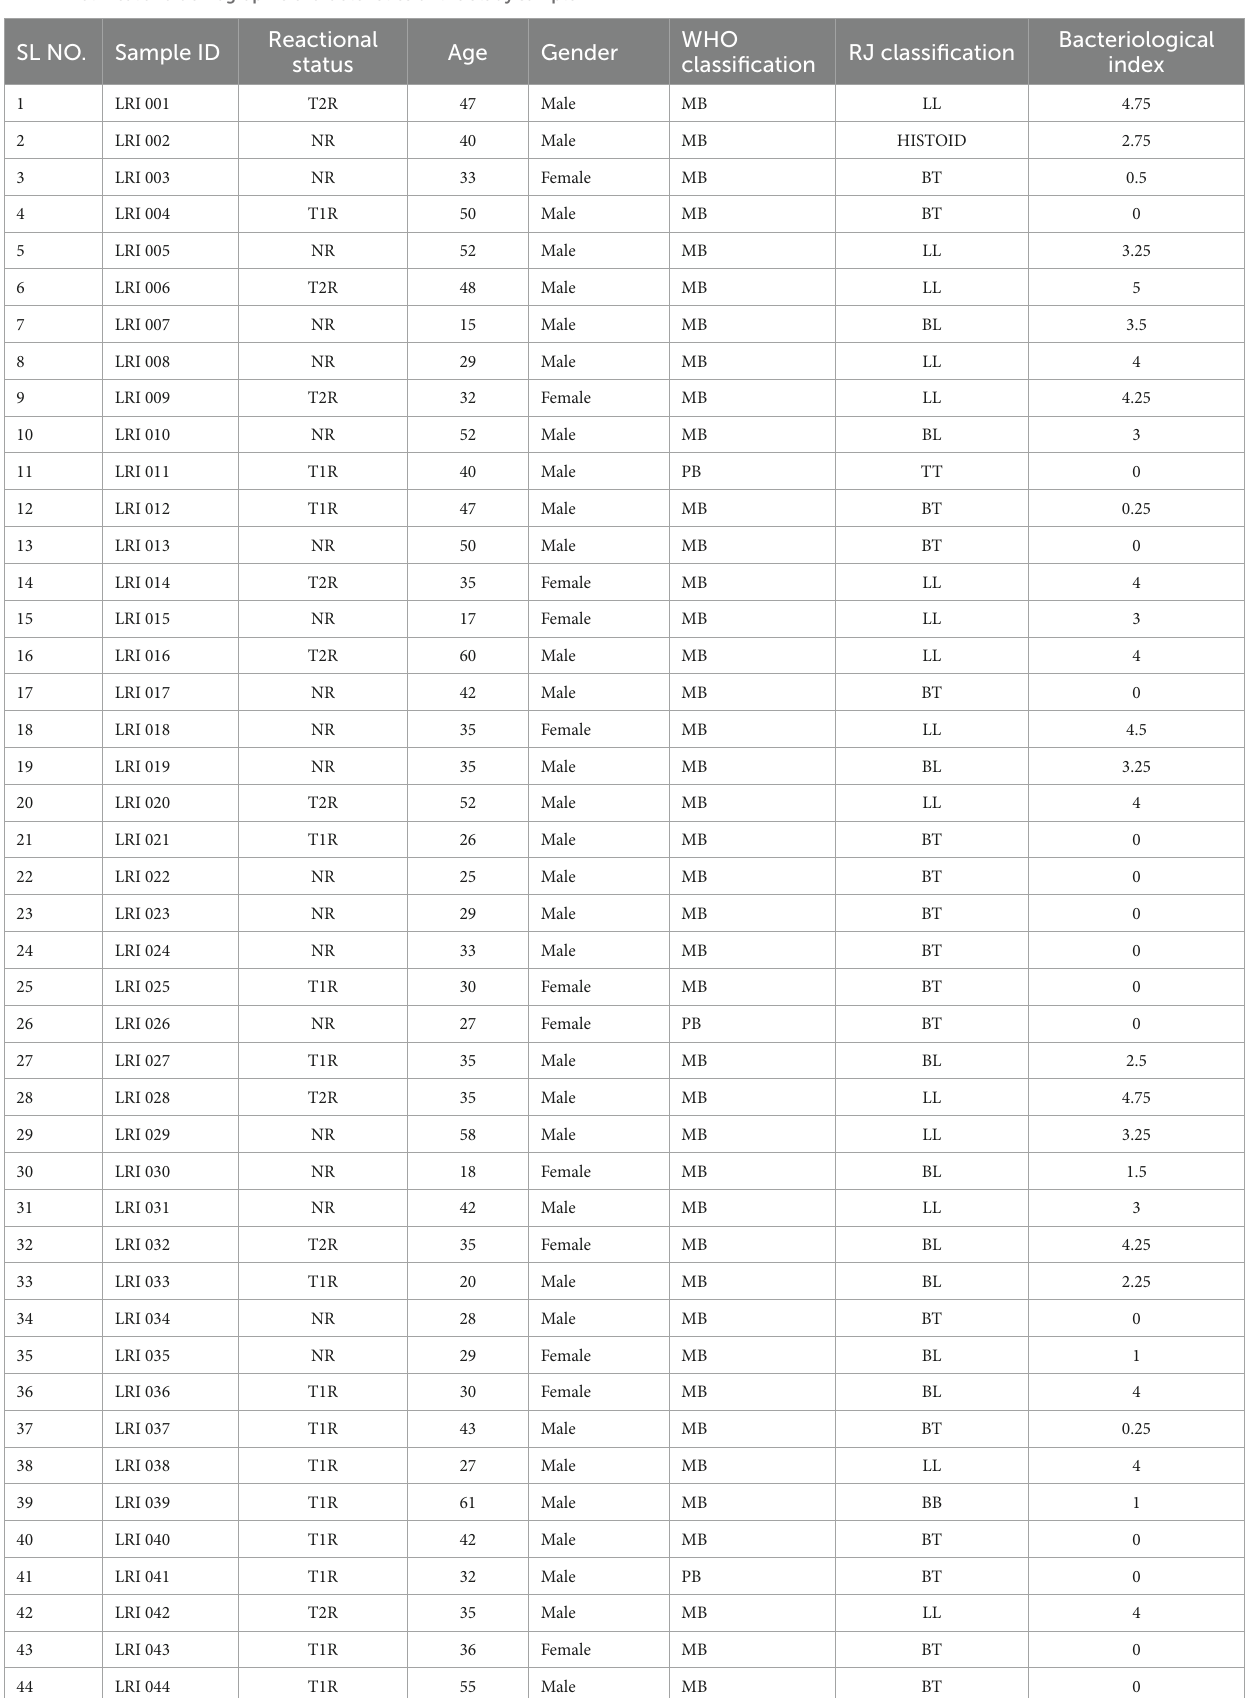
TABLE 1 Clinical and demographic characteristics of the study sample. SL